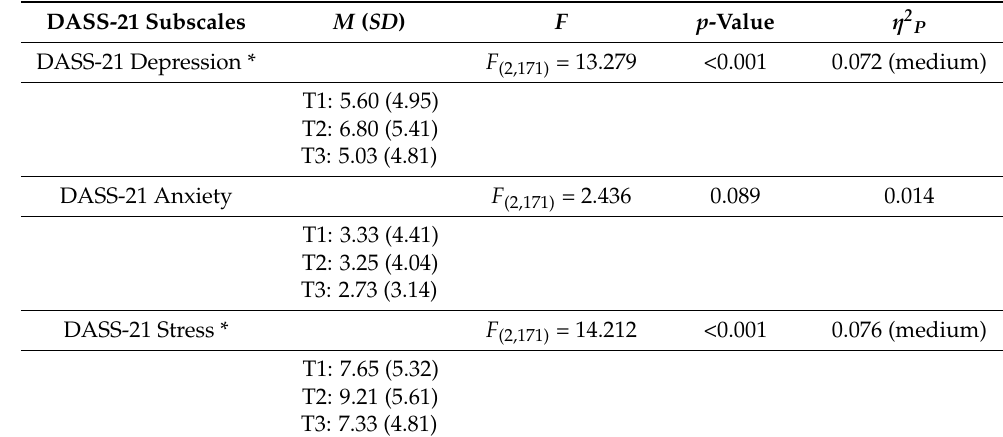
Table 2. The difference between the three periods in levels of stress, anxiety, and depression, as measured with the DASS-21 ( n =